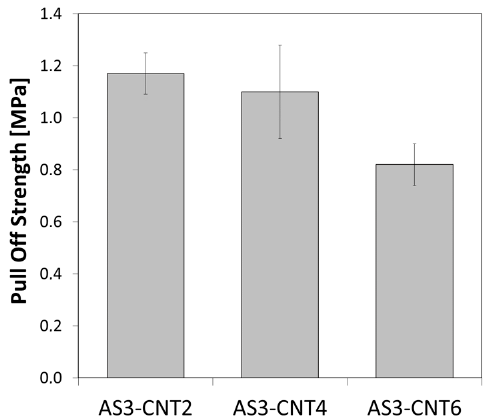
Figure 5. Pull-off strength of silane based coatings at increasing CNT filler content (three replicates for each coating).